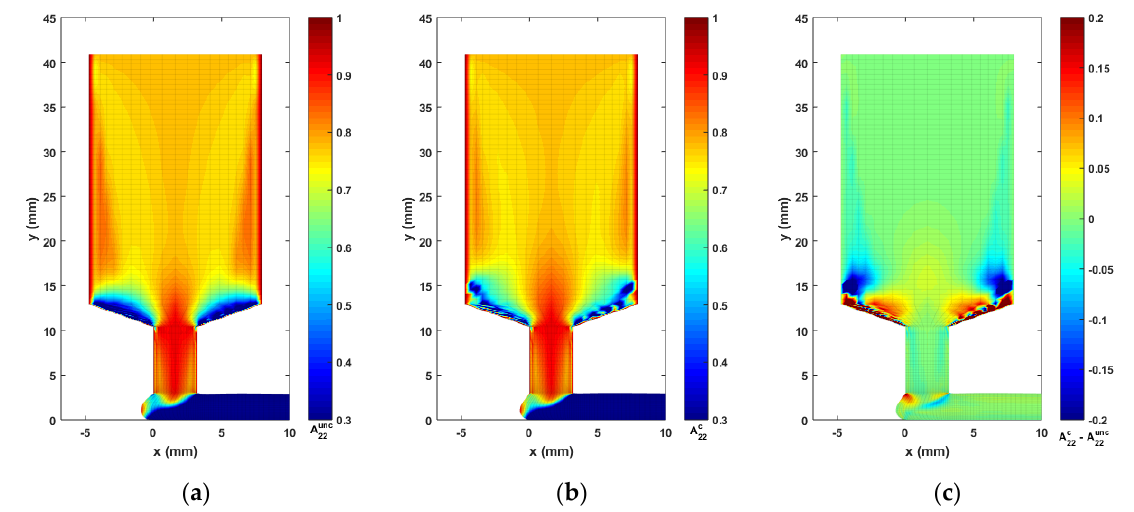
Figure 11. Fiber orientation tensor component contour of A 22 : ( a ) the uncoupled solution; ( b ) the fully coupled solution; ( c ) difference between the fully coupled and uncoupled solutions.